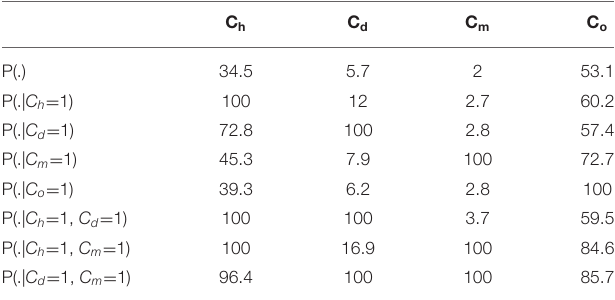
TABLE 2 | Probability of chronic